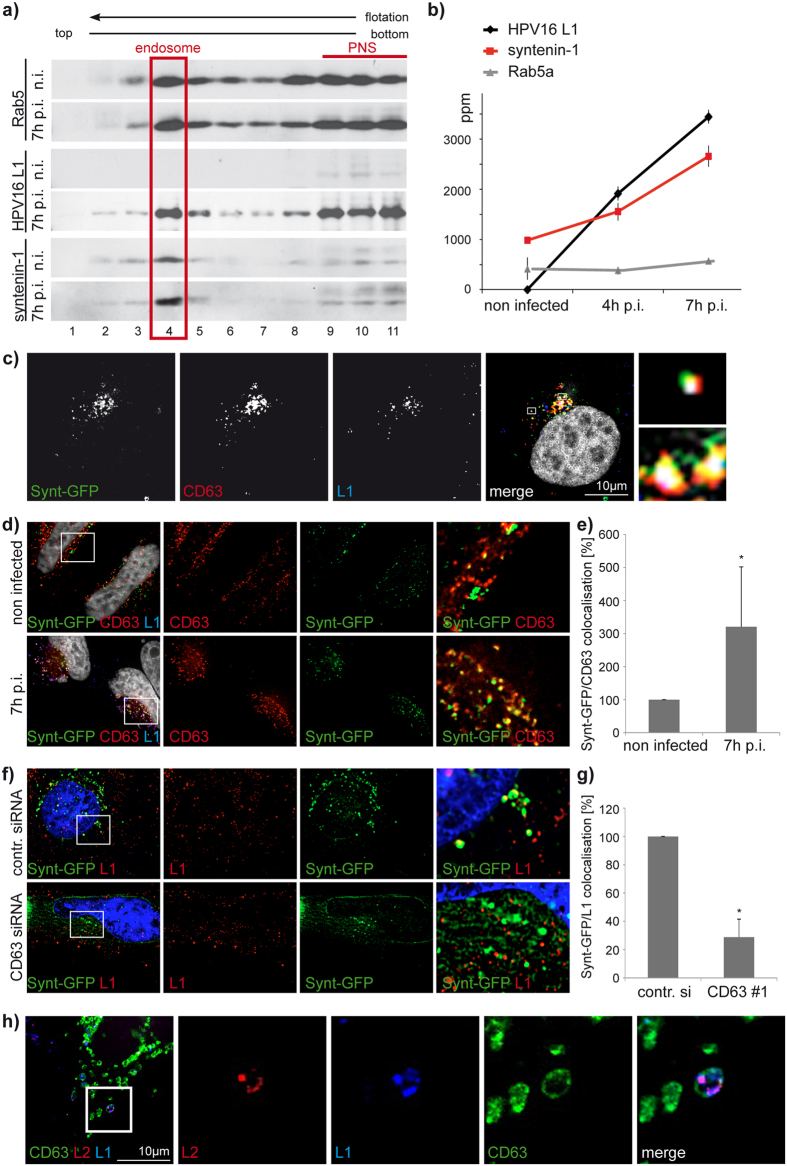
Recruitment of syntenin-1 to endosomes after HPV16 infection.(a,b) Endosomal syntenin-1 increased according to HPV incubation time. Western blot (a) and label-free quantitative mass spectrometry (b) of L1, syntenin-1 and Rab5/Rab5a in HeLa cells infected with HPV16 PsV for the indicated time points. Rab5 marks early endosomes and serves as loading control. Fraction 4 in the Western blot shows endosomal fractions used for mass spectrometry. Fractions 9 to 11 represent post-nuclear supernatant (PNS) rich in soluble forms of Rab5. (c–e) Syntenin-GFP expressing HeLa cells show significantly increased colocalisation of CD63 and L1 at 7 hours post infection (7h p.i.). (c,d) Representative pictures show immunofluorescence of L1 (blue), CD63 (red), and syntenin-GFP (green) expressing HeLa cells. (e) Quantification of syntenin-GFP-colocalising CD63 pixels was performed by analysis of at least 10 images (3-5 cells per image) using Colocalisation Software 4.7 (Zeiss). *P < 0.05 compared to control. (f,g) Syntenin-1 recruitment to HPV L1 positive endosomes is significantly decreased after CD63 depletion. (f) Shows representative pictures of syntenin-GFP (green) and L1 (red) after 7 h infection in control or CD63 siRNA treated HeLa cells. (g) Quantification of syntenin-GFP-colocalising L1 pixels was performed by analysis of at least 20 images (3-5 cells per image) using Colocalisation Software 4.7 (Zeiss). *P < 0.05 compared to control. (h) CD63 positive endosomes contain both L1 and L2. Representative pictures show HeLa cells transfected with CD63-GFP expression plasmid and stained with pAb K75 and mAb L2-1. CD63-GFP is shown in green, L2 in red, L1 in blue and the nucleus in grey.